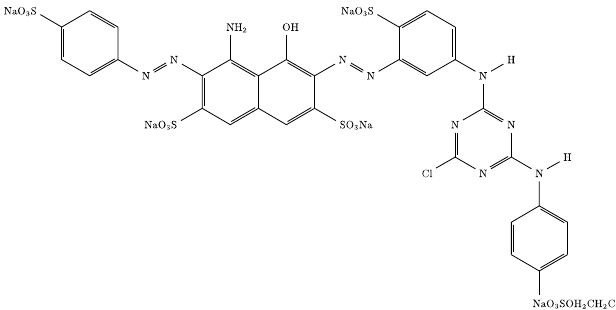
Figure 11. Chemical structure CAS No. 186554-27-8. Catalysts 2019 , 9 , x FOR PEER REVIEW